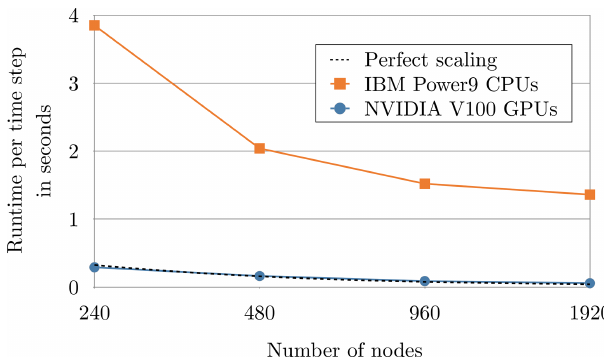
Figure 8. Strong scaling comparison between the GPU-optimised version and initial CPU version of the spectral transform dwarf on Summit at the Oak Ridge National Laboratory. All of these simula- tions use 2.5km resolution ( N T = 3999) with 240 fields. The GPU version uses six V100 GPUs per node, which leads to a maximum number of 11520 GPUs. The perfect scaling was chosen such that it goes through the GPU result at 480 nodes to illustrate the scaling efficiency of the GPU version. The points were connected with lines for the purpose of improving the readability of the